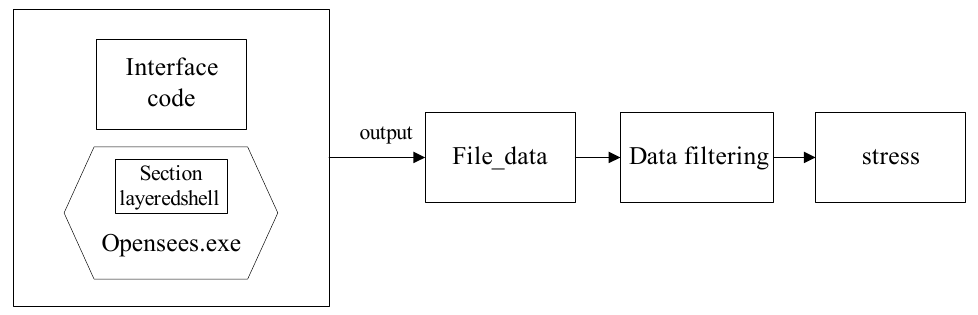
Figure 8. Stress extraction process.